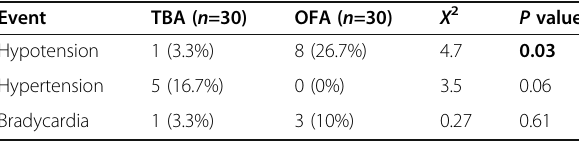
Table 2 Comparison between groups as regards vital data events